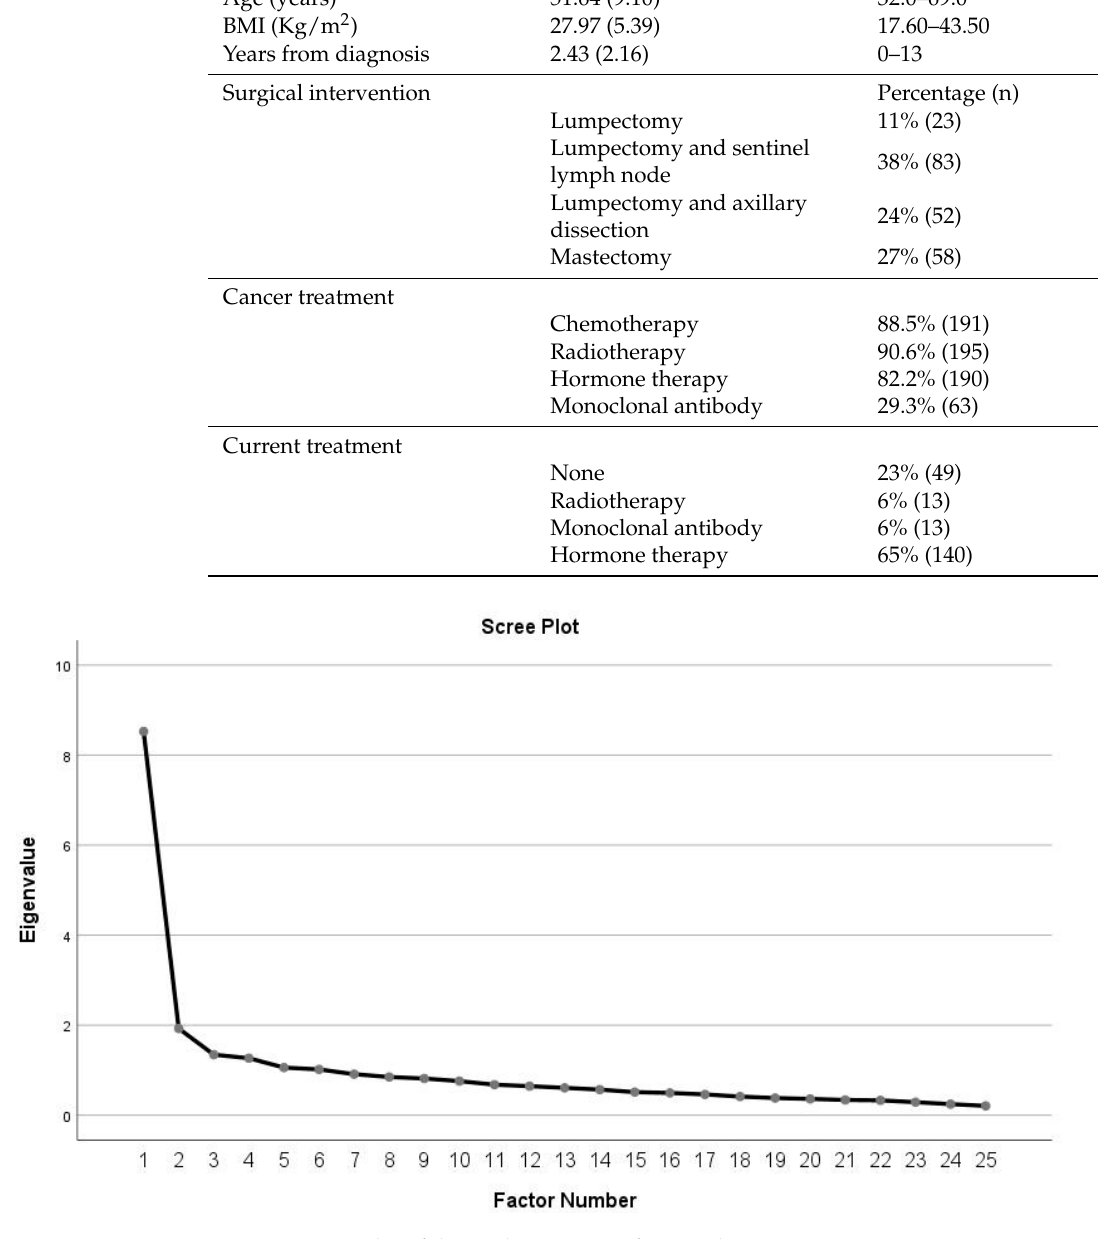
Figure 1. Scree plot of the exploratory one-factor solution. The ULFI-Sp showed a high degree consistency, as illustrated by the high Cronbach value ( α = 0.916) with an individual item range between 0.868 and 0.875. The correlation between the ULFI total score and the regression score obtained from the one-factor solution MLE was also high ( α = 0.996). The correlation between items and the regression score from MLE, communalities, and the average score for each item is shown in Table 2. The results of the CFA revealed a poor fit, with CFI = 0.802 and RMSEA = 0.075 (Table 3). Table 2. Twenty-five-item average score, correlation and communalities from ULFI-Sp in BCS and fourteen-item short version communalities.